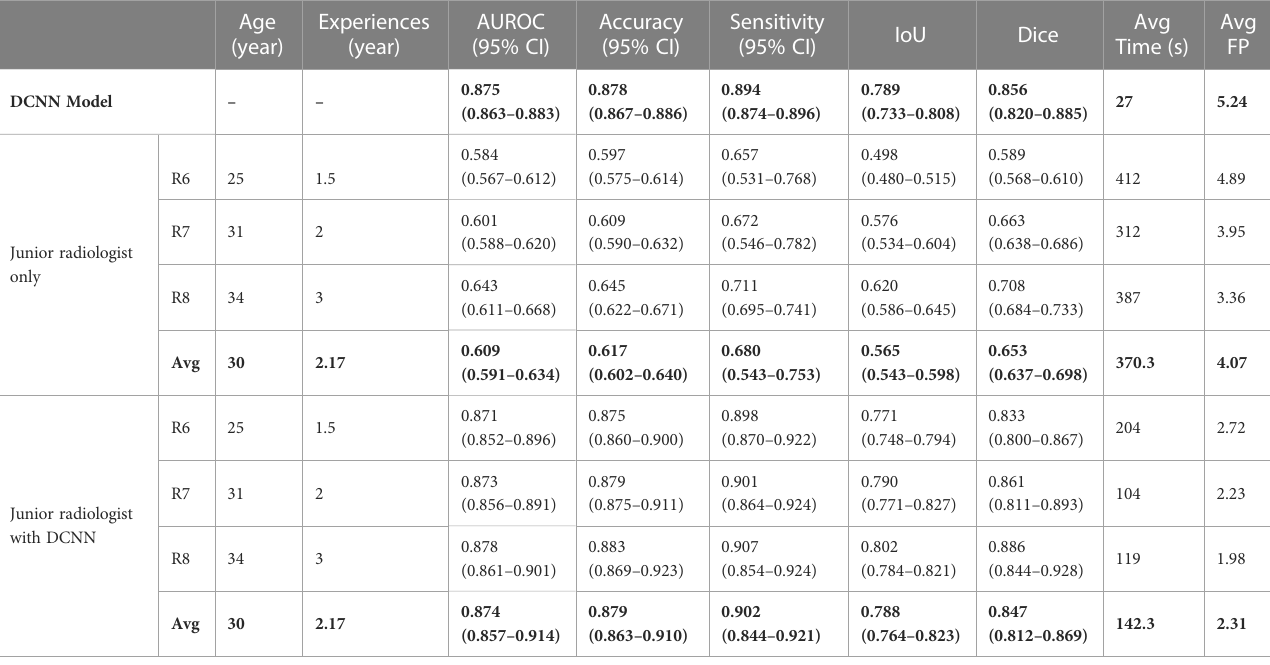
TABLE 3 A comparison of the DCNN model and three junior radiologists without and with the DCNN